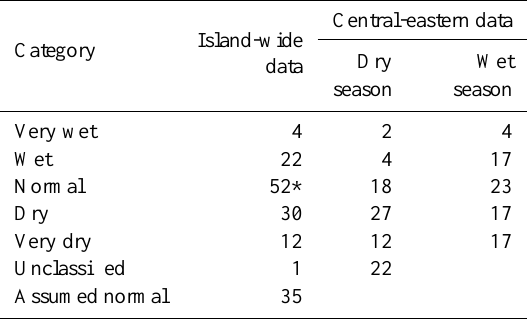
Table 3. Classification frequencies for island-wide and central- eastern